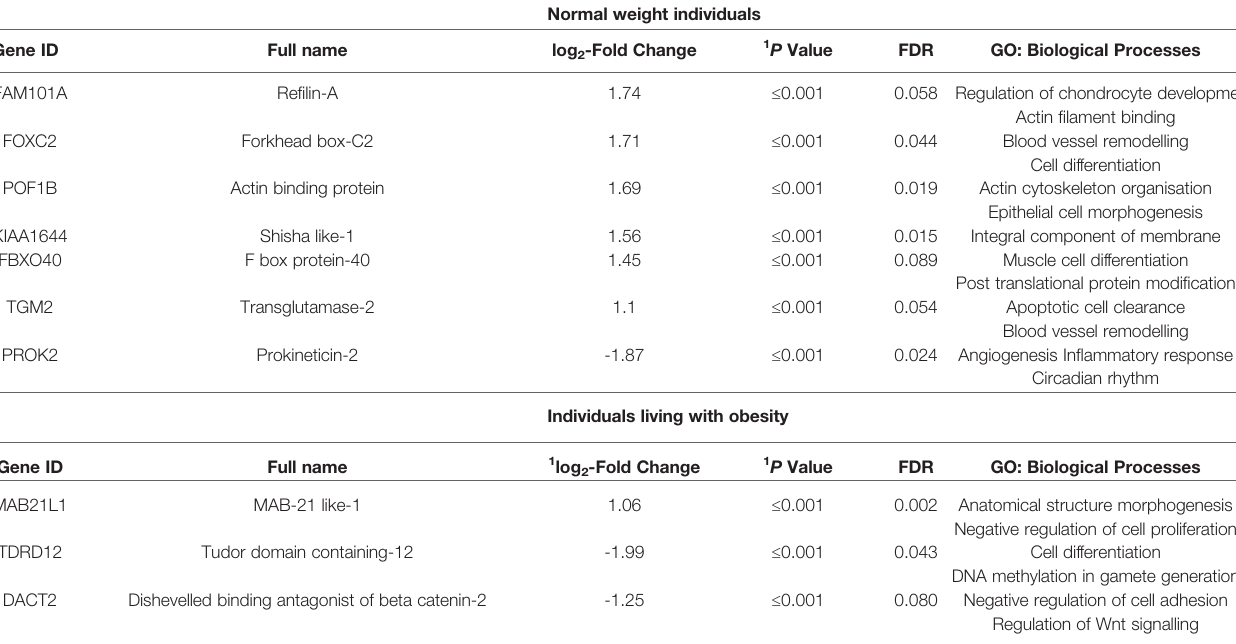
TABLE 6 | Remodelling associated genes signi fi cantly modulated by 12-weeks intervention with LC n-3 PUFAs in normal weight and individuals living with obesity. Normal weight individuals